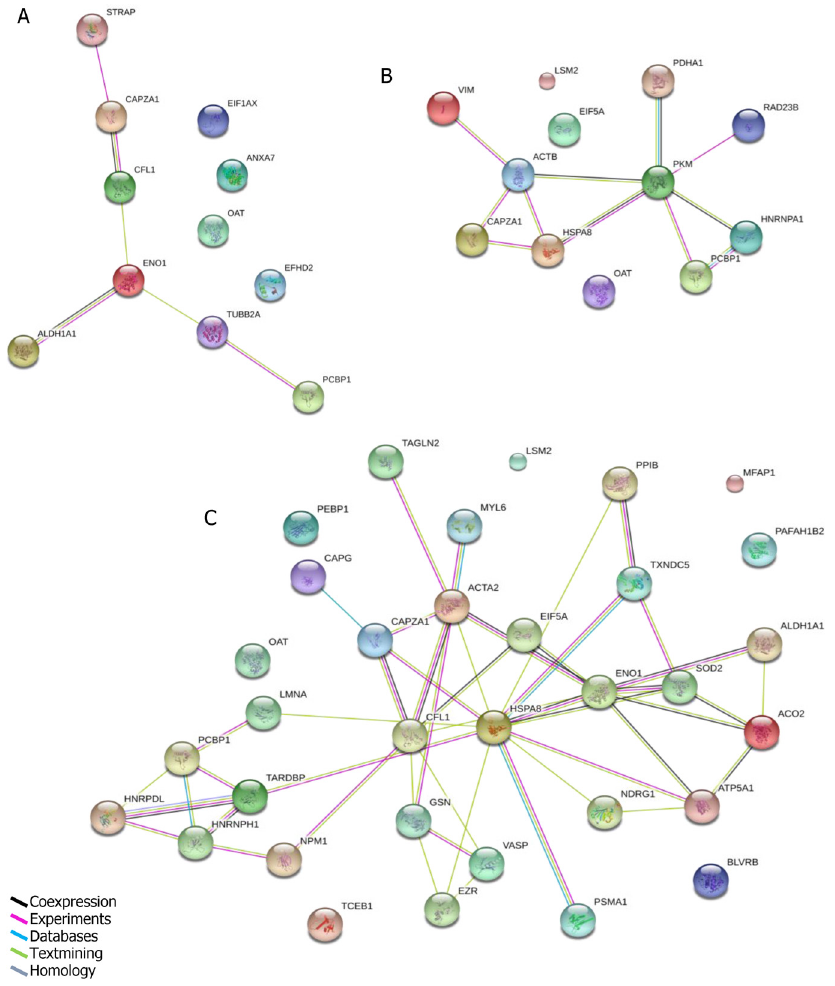
Fig 3. The protein interaction network diagrams of 24h(A), 48h(B)and 72h(C)were analyzed by String software. Colored lines denote interactions.